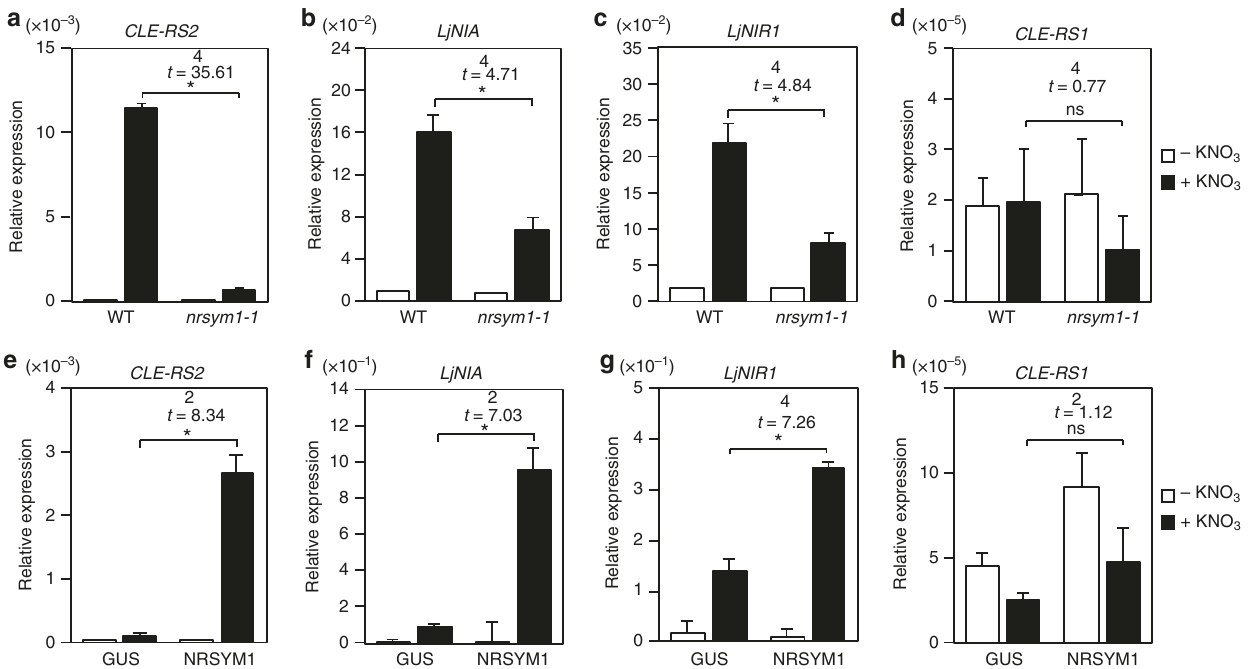
Fig. 5 The effect of the nrsym1 mutation or NRSYM1 constitutive expression on gene expression. a – d Real-time RT-PCR analysis of ( a ) CLE-RS2 , ( b ) LjNIA , ( c ) LjNIR1 , and ( d ) CLE-RS1 expression in roots of WT and the nrsym1-1 mutants. e – h Real-time RT-PCR analysis of ( e ) CLE-RS2 , ( f ) LjNIA , ( g ) LjNIR1, and ( h ) CLE-RS1 expression in transgenic hairy roots produced from WT containing the pLjUBQ:GUS or pLjUBQ:NRSYM1 constructs. Each cDNA sample was prepared from total RNA derived from an uninoculated whorl of roots grown in the presence of 0 or 10 mM KNO 3 for 24 h. The expression of LjUBQ was used as the reference. Error bars indicate SEM ( n = 3 independent pools of roots). * P < 0.05 by Student ’ s t -test. ns, not signi fi cant. Degrees of freedom are shown above the t